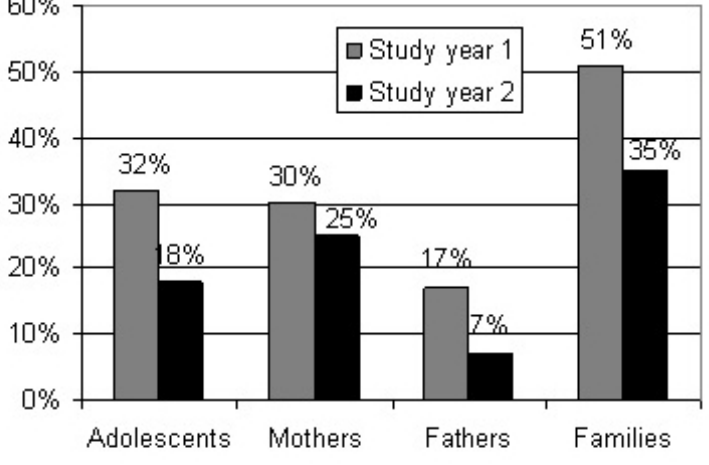
Figure 6. Proportions of adolescents, mothers, fathers, or at least one of these in the same family, logged in once or more.